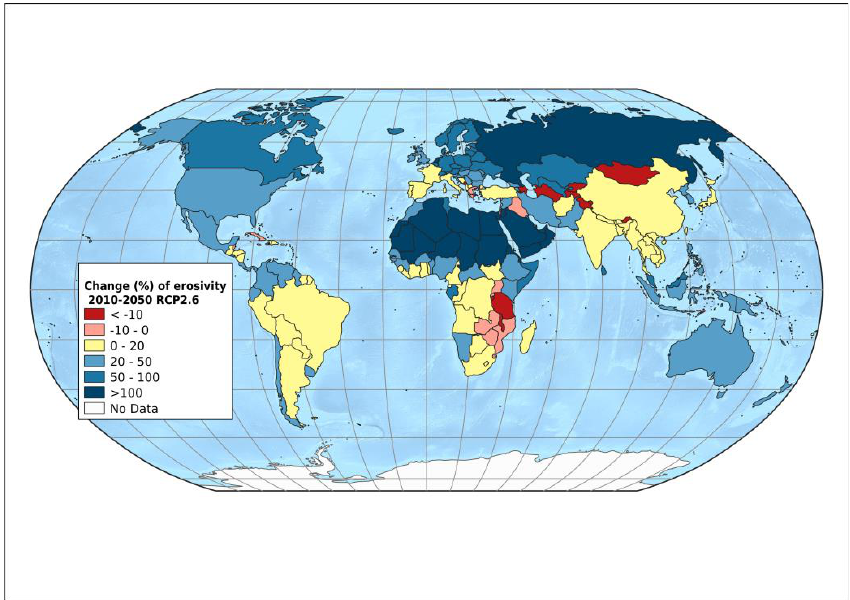
Figure 8. Change (%) of erosivity of the period 2010 − 2050 for the scenario RCP2.6 [56].